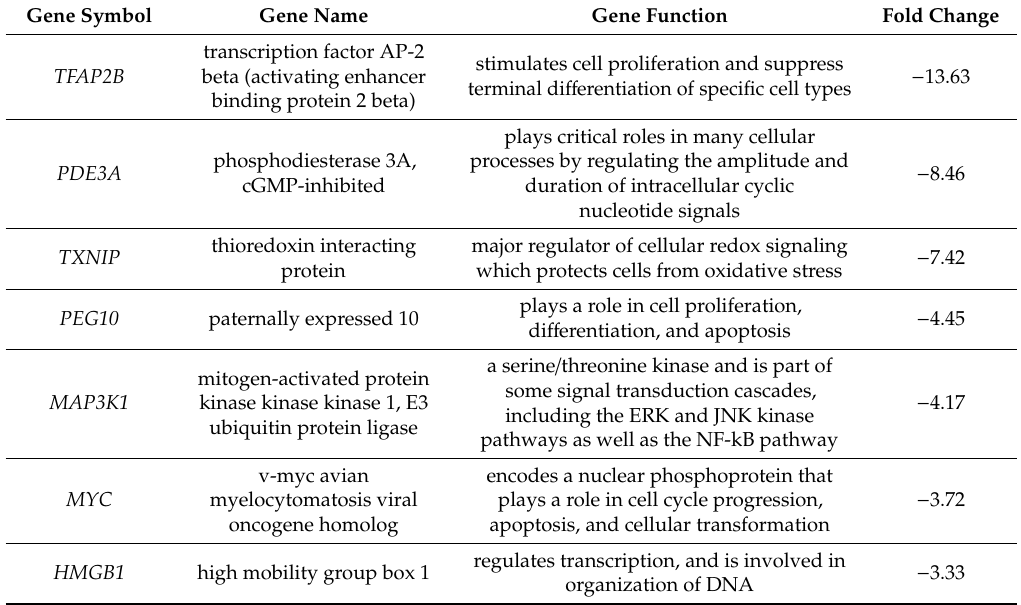
Table5. Thelistofmostdownregulatedgenesinvolvedinanti-apoptoticprocessesinbortezomib-treated SH-SY5Y cells compared to controls. Gene function according to NCBI Gene